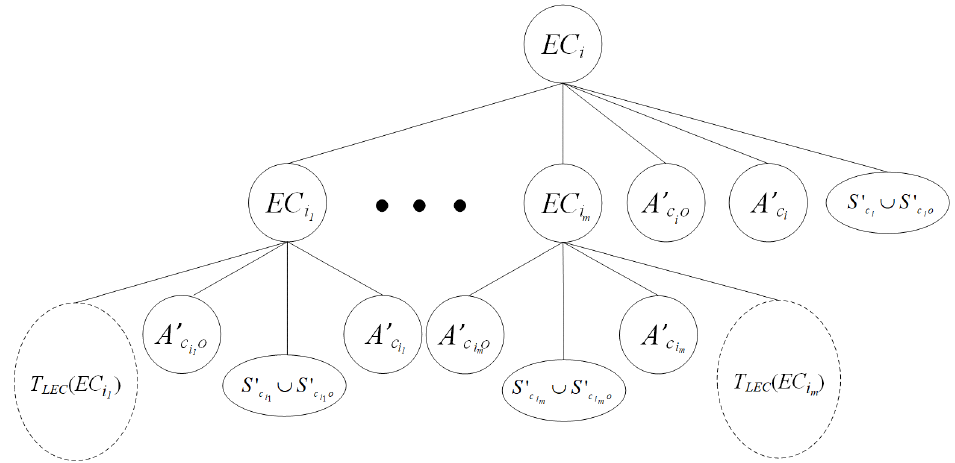
Figure 7. Structure of the entity class classification